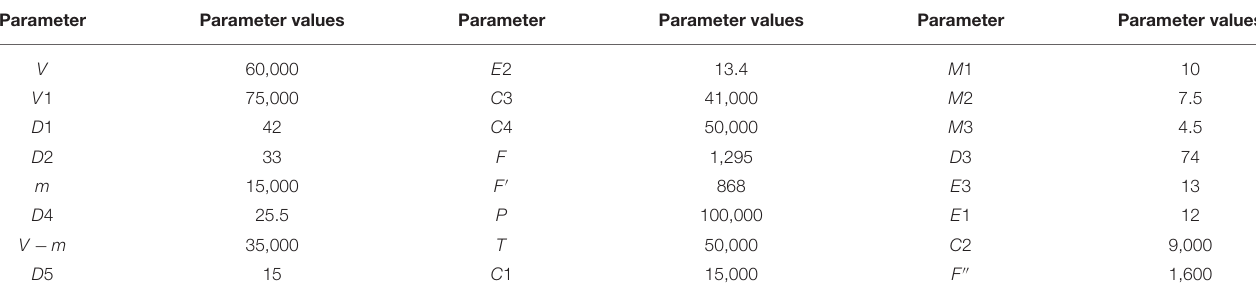
TABLE 4 | Classifications of data